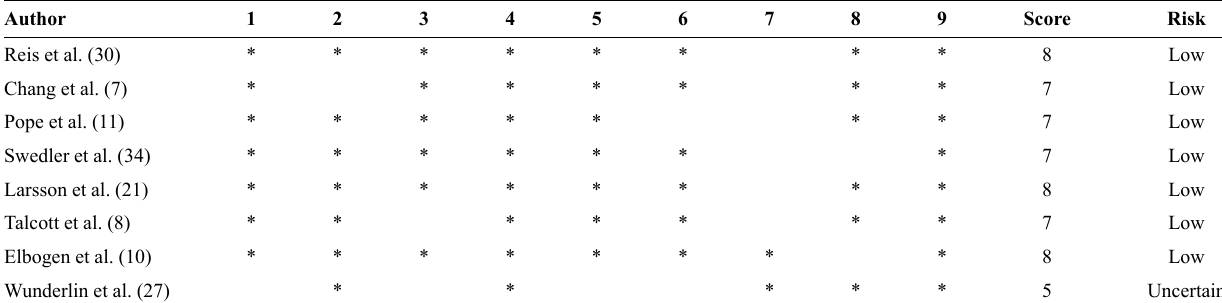
Table 3 - Risk of bias of the studies with the Newcastle-Ottawa Scale for cohort studies.